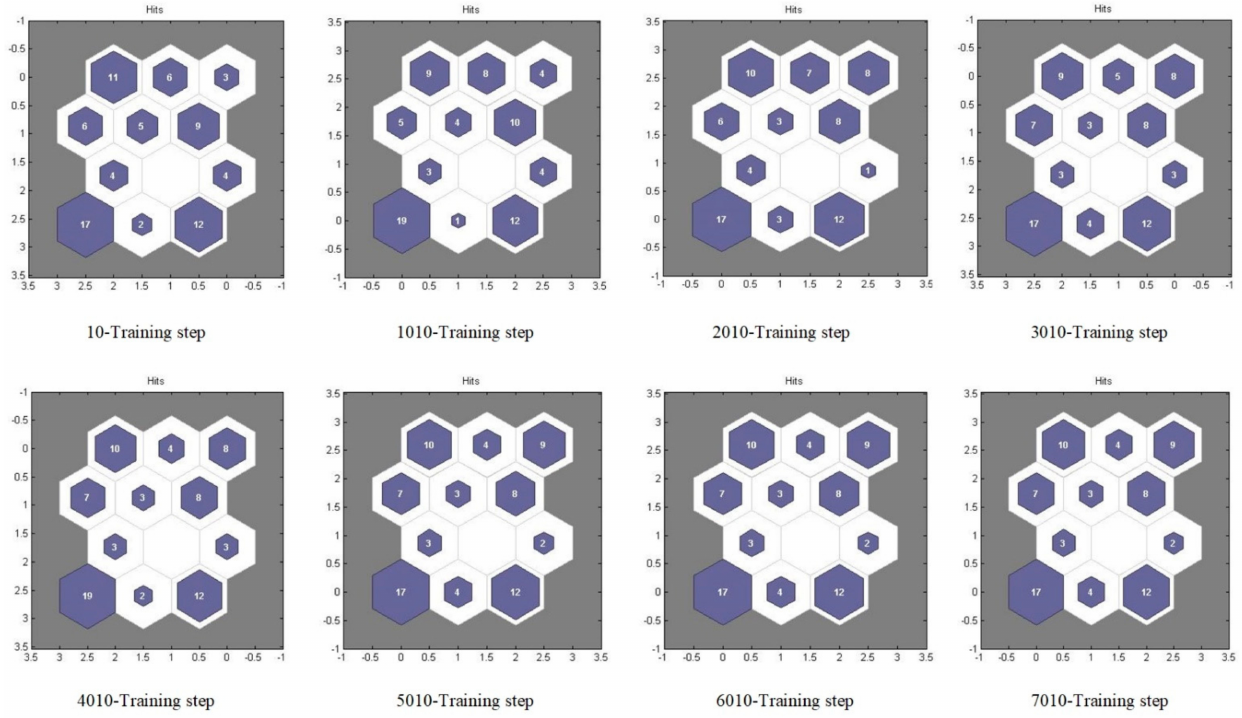
Figure 4. Results of clustering based on